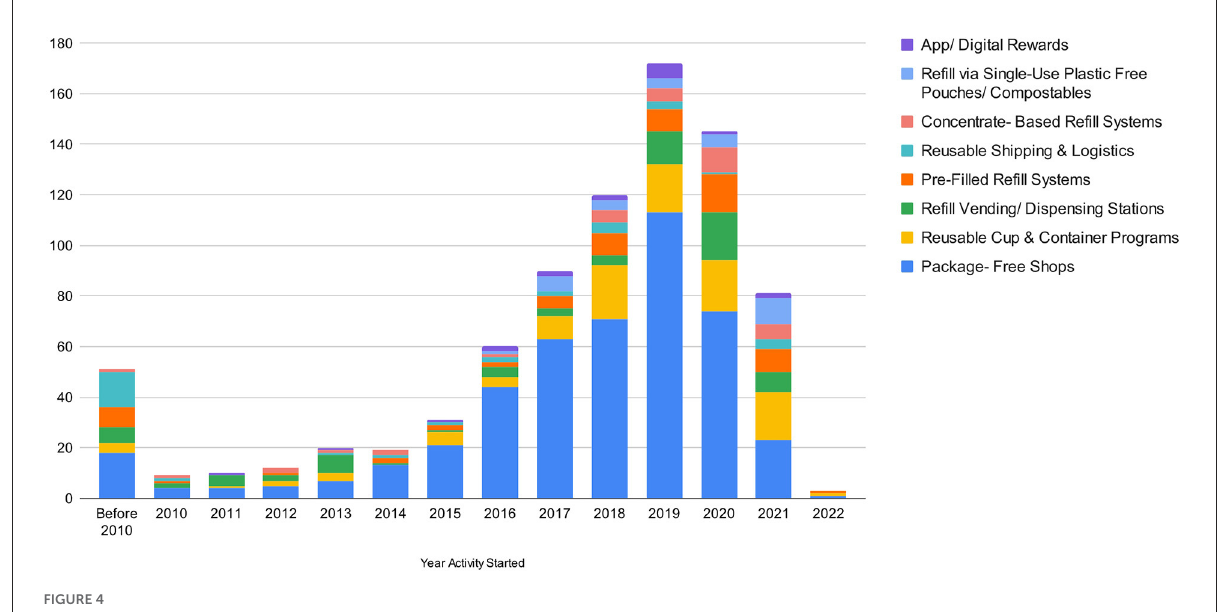
FIGURE4 Reuse and refill solutions by launch year.